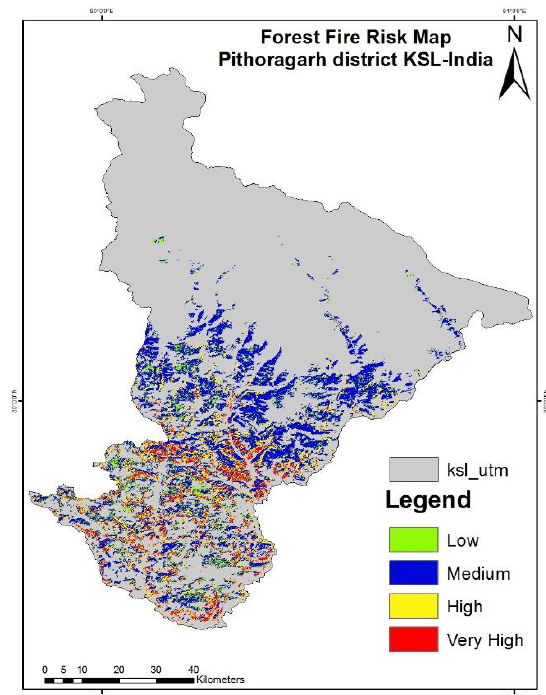
Fig 5: Forest Fire Prone Areas in Indian part of KSL